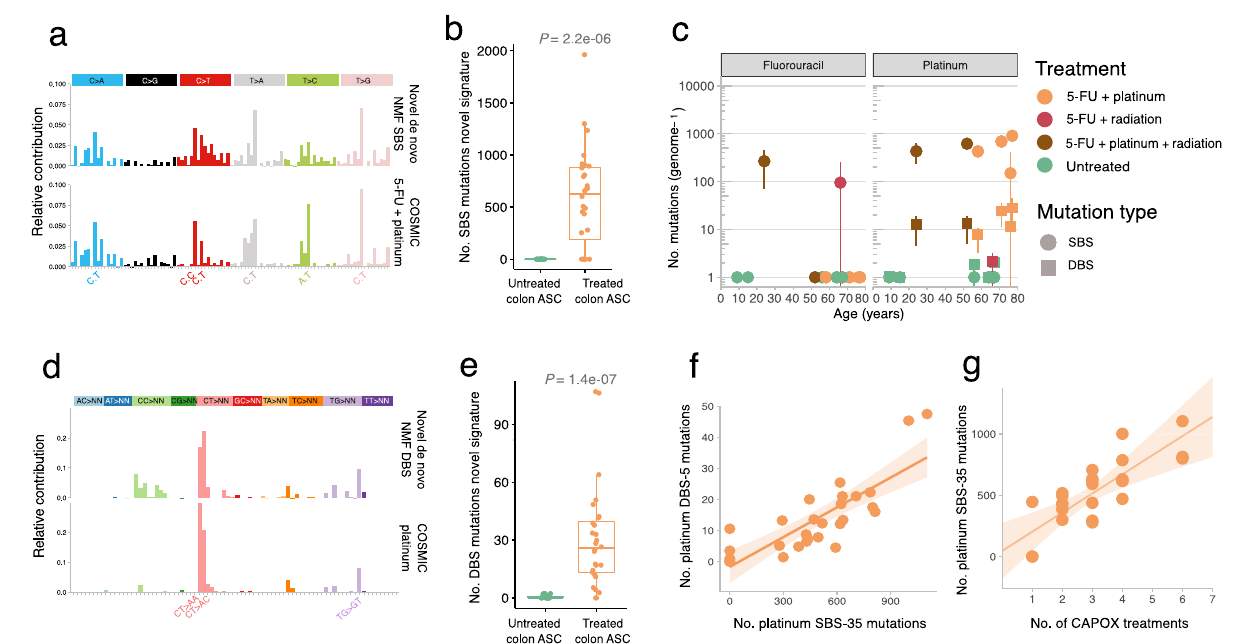
Fig. 3 | Chemotherapy-induced mutations in healthy colorectal ASCs. a The distinct extracted de novo SBS signature in treated healthy colorectal tissue resembles a mix of the COSMIC 5-FU and platinum mutation signatures (cosine sim=0.88). b Boxandwhiskerplotindicatingtherelativemutationcontributionof the treated speci fi c SBS mutation signature from colorectal ASCs between CapOx- treated ( n =7) and untreated ( n =5) colorectal donors. The here shown box and the median (vertical line inside the box), the extremes (whiskers) and the single data points (single dots). A Wilcoxon rank-sum test between every cohort was performed and the p value is illustrated at the top of the plot. c 5-FU and